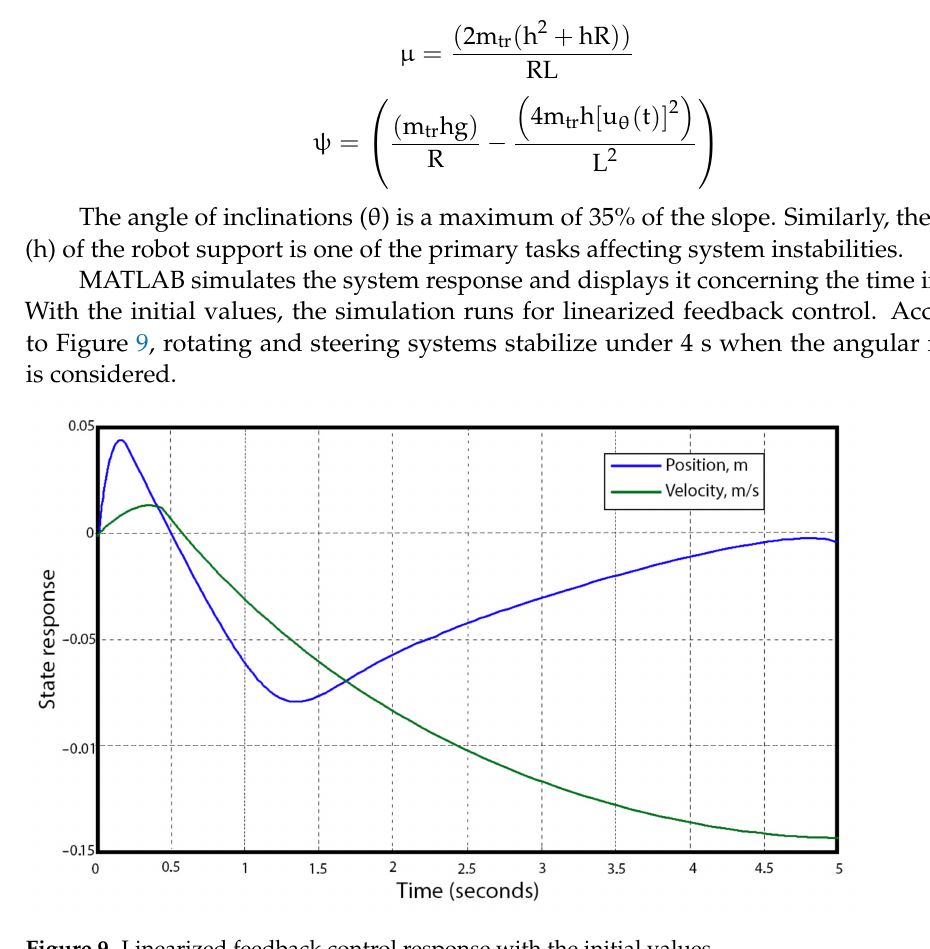
Figure 9. Linearized feedback control response with the initial